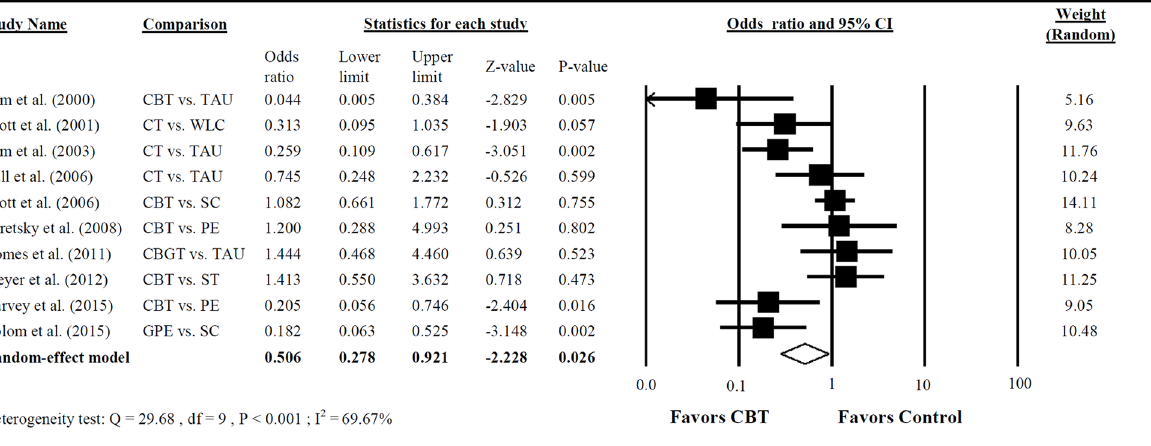
PLOS ONE | https://doi.org/10.1371/journal.pone.0176849 May 4,